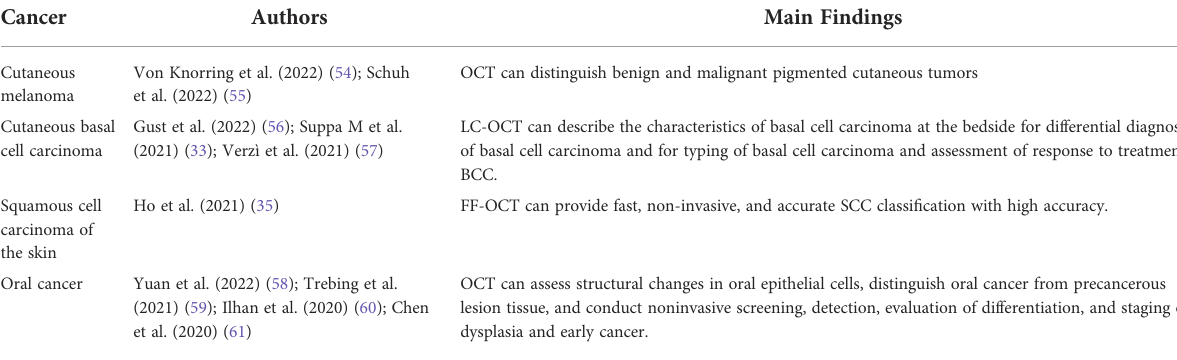
OCT can distinguish benign and malignant pigmented cutaneous tumors